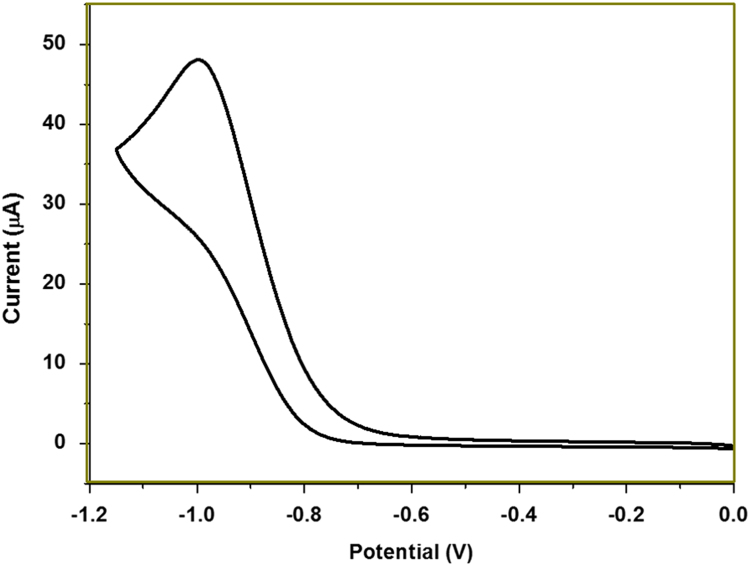
Cyclic voltammogram analysis of Pd–Azo–POP. (CH2Cl2. Scan rate 50 mV s−1).